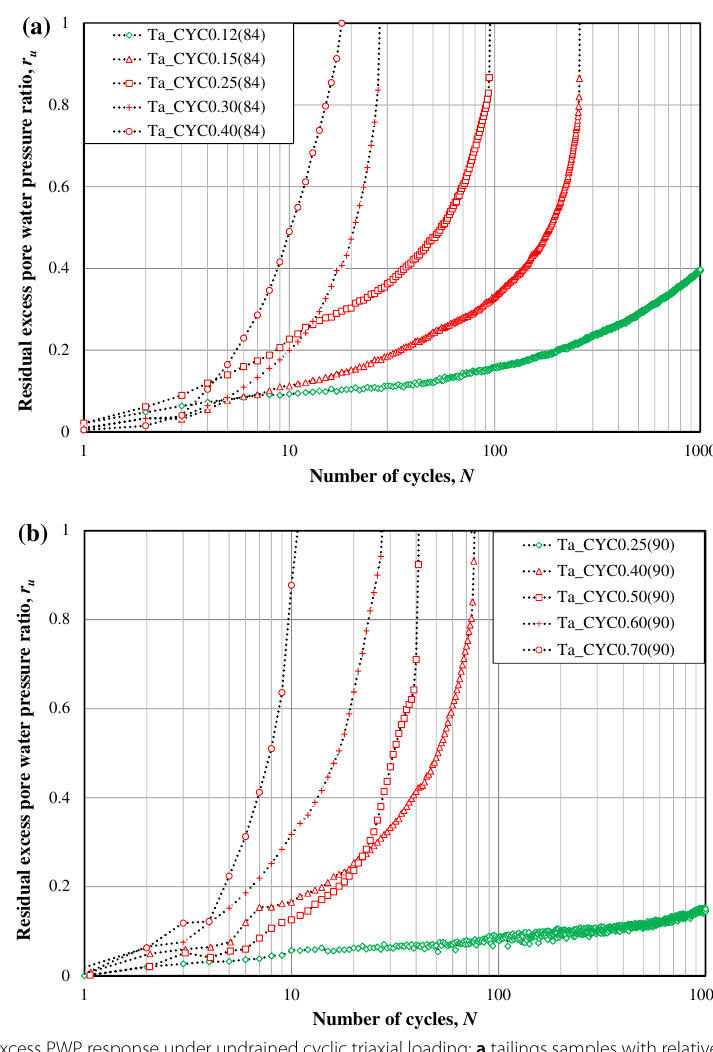
Fig. 5 Excess PWP response under undrained cyclic triaxial loading: a tailings samples with relative compaction 84%; b tailings samples with relative compaction